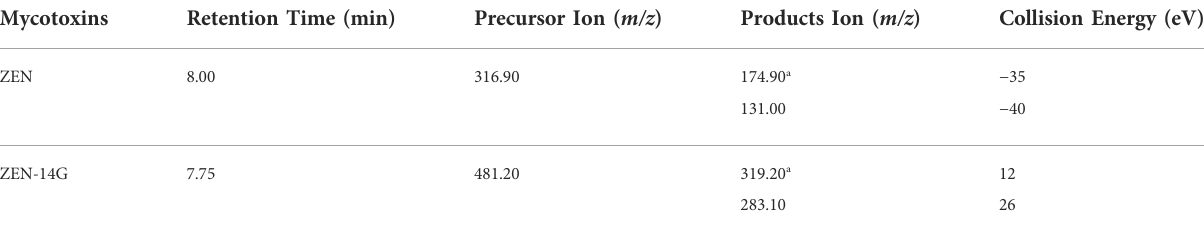
TABLE 1 MS/MS parameters of ZEN and ZEN-14G.